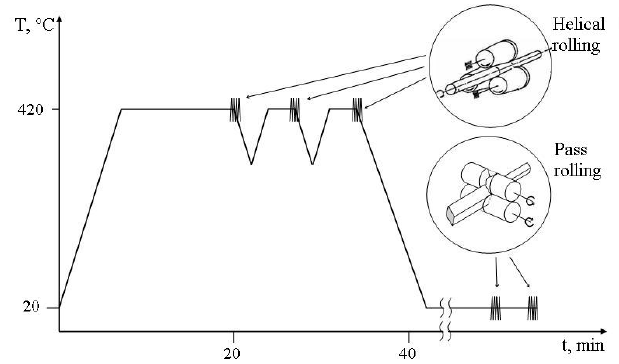
Figure 1. Processing scheme of combined rolling.